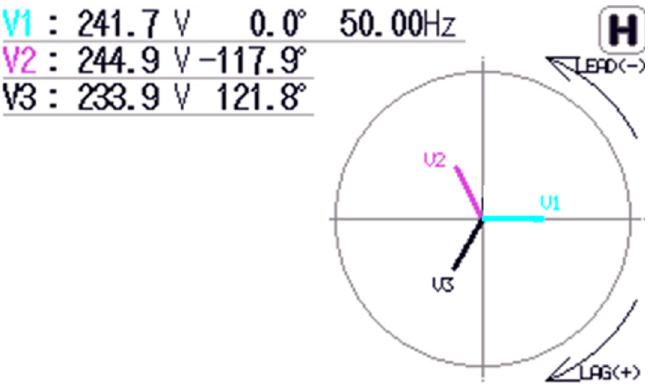
Figure 1. The angular asymmetry between voltage vectors: reference grid measurement.